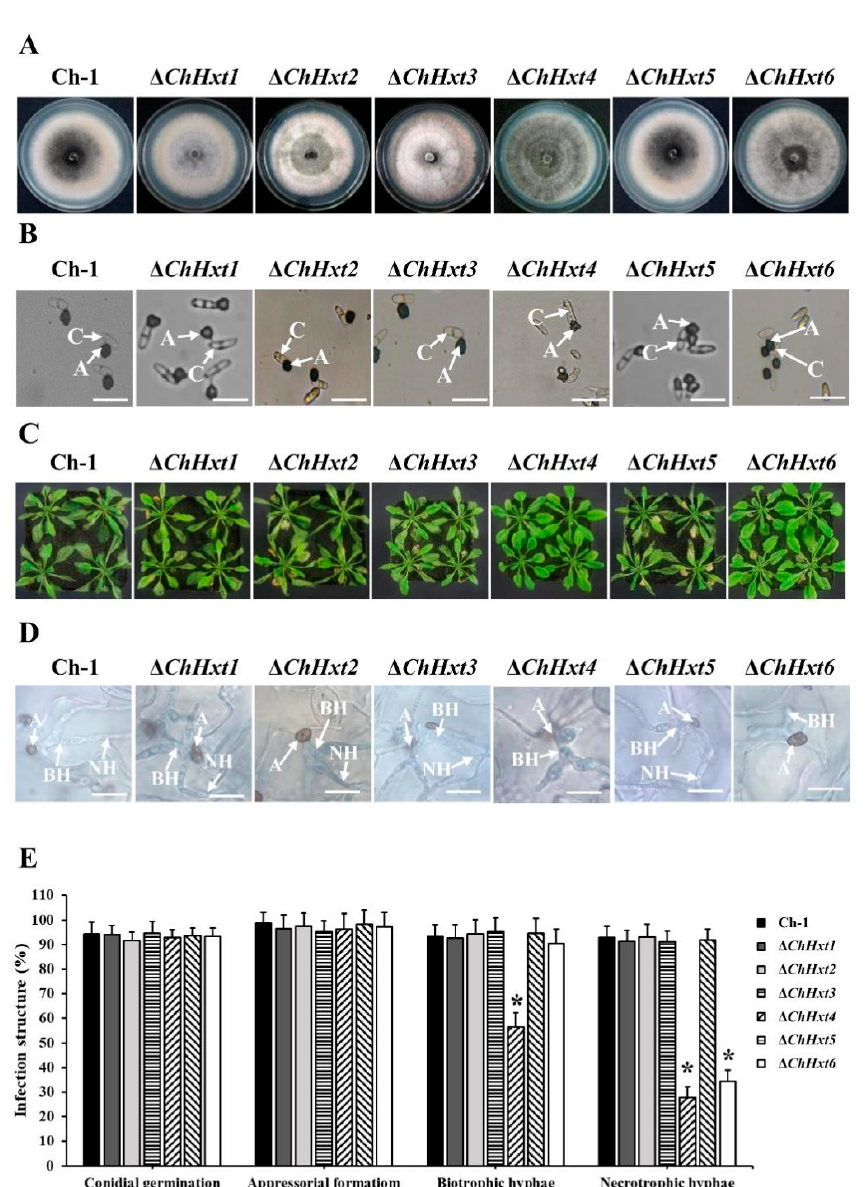
Figure 3. Characterization of ChHxt1~ChHxt6 knockout mutants in C. higginsianum . ( A ) Colony morphology of the mutants. Wild-type and mutant strains were cultured for 7 days on PDA in darkness at 25 °C. ( B ) Conidial germination of the mutants. Conidia of the wild-type and mutants were cultured on plastic coverslips at 25 °C for 24 h, and conidia germinated to produce appressoria were observed under microscope. A: appressoria; C: conidia; bar = 20 μ m. ( C ) Virulence test of the mutants. Observation of the symptoms on 6-week-old Arabidopsis leaves at 4 days post-inoculation. ( D ) Infection structures at 48 h post-inoculation. The Arabidopsis leaves inoculated conidia of the wild-type and mutants were collected at 48 h post inoculation, after decoloring with methanol: chloroform: glacial acetic acid (6:3:1, v / v / v ) and staining with trypan blue (0.4%). Infection structures were observed under microscope at 48 h post-inoculation. A: appressoria; BH: biotrophic hyphae; NH: necrotrophic hyphae. Bar = 20 μ m. ( E ) Generation rate of infection structures. To calculate the infection structure generation rate, at least 100 infection structures were observed, and each test was repeated three times. Bars indicate means and standard deviations of generation rates of infection structures. Asterisks represent significant differences between the Ch-1 and other strains by LSD test at p = 0.05.